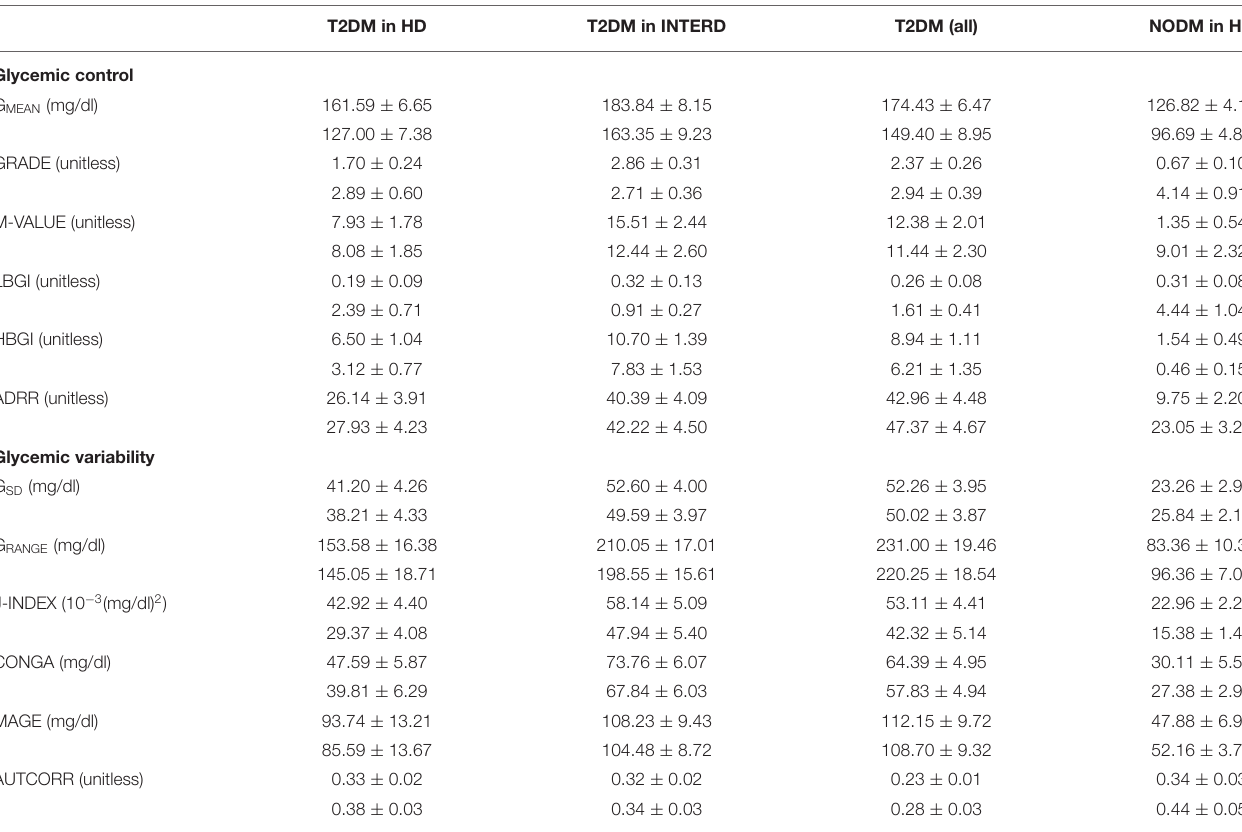
TABLE 2 | Indices of glycemic control and glycemic variability derived by SMBG and FGM (upper and lower, respectively) in T2DM patients during hemodialysis sessions (HD), during interdialytic periods (INTERD), and with all values; in NODM patients, during HD (mean ± SEM). T2DM in